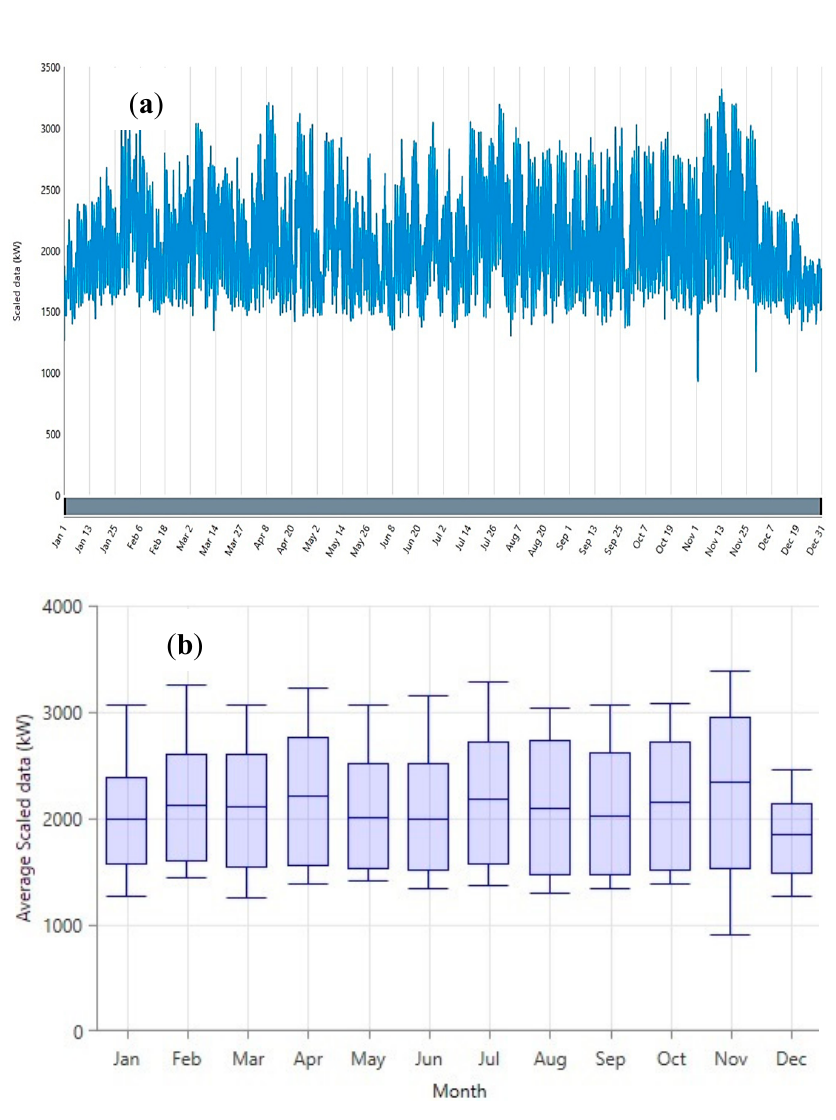
Figure 4. Demand load profile ( a ) hourly graph ( b ) monthly averaged box plot graph .